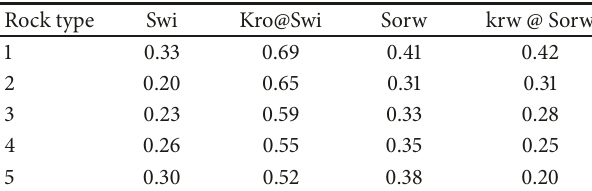
Table 1: Average porosity, average permeability, and J function for each rock type.